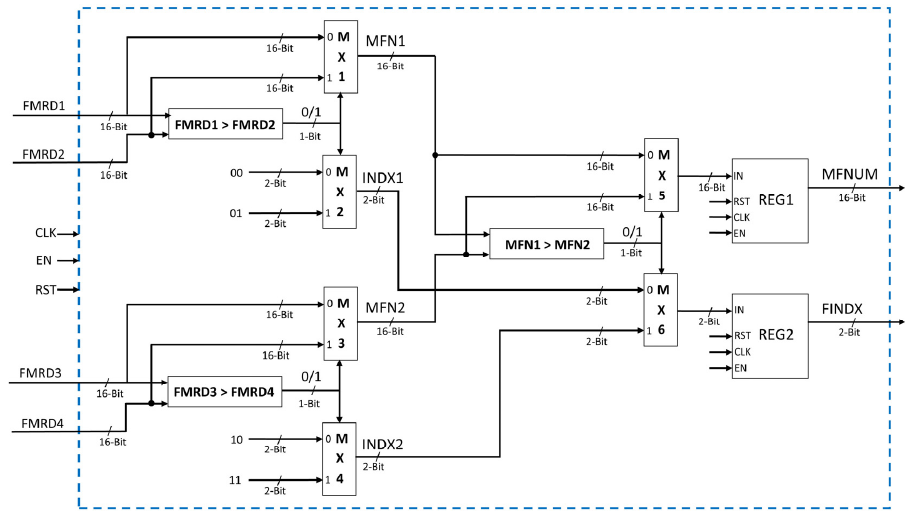
Figure 7. Proposed VLSI architecture of Minimum Frame Number Computation Module.